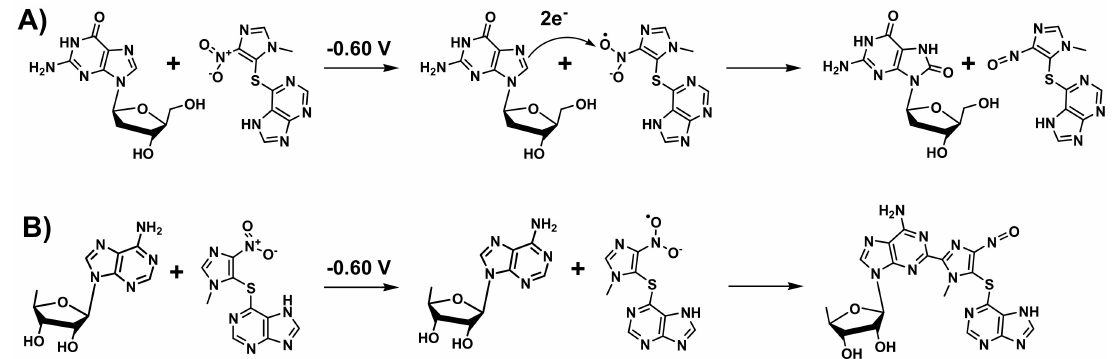
Scheme 2. Proposed mechanism of interaction of AZA with DNA bases: ( A ) formation of 8-oxo-deoxyguanosine and ( B ) adducts with adenine